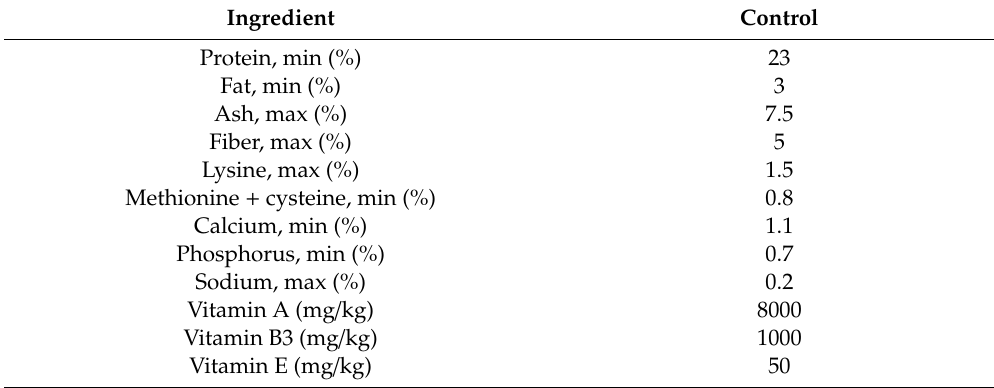
Table 1. Nutritional composition of the standard rodent fodder used throughout the study—Provider: Agropol ([28], LSM diet).